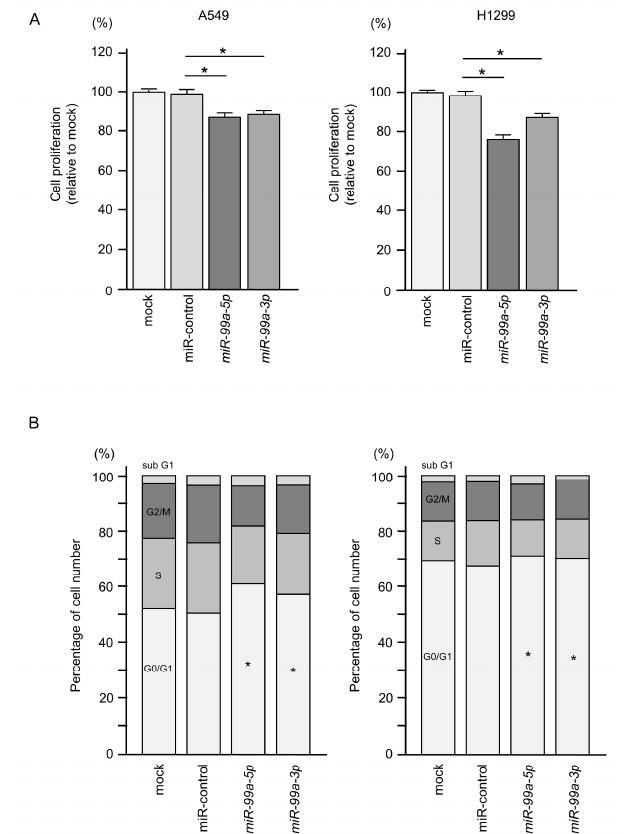
Figure 3. Functional assays of cell proliferation and cell cycle arrest following ectopic expression of miR-99a-5p or miR-99a-3p in LUAD cell lines (A549 and H1299 cells). ( A ) Cell proliferation assessed using XTT assays at 72 h after miRNA transfection (* p < 0.0001). ( B ) Flow cytometric analysis of the cell cycle phase distribution of control cells and cells transfected with miR-99a-5p or miR-99a-3p . Cells were evaluated at 72 h after miRNA transfection (* p < 0.0001).